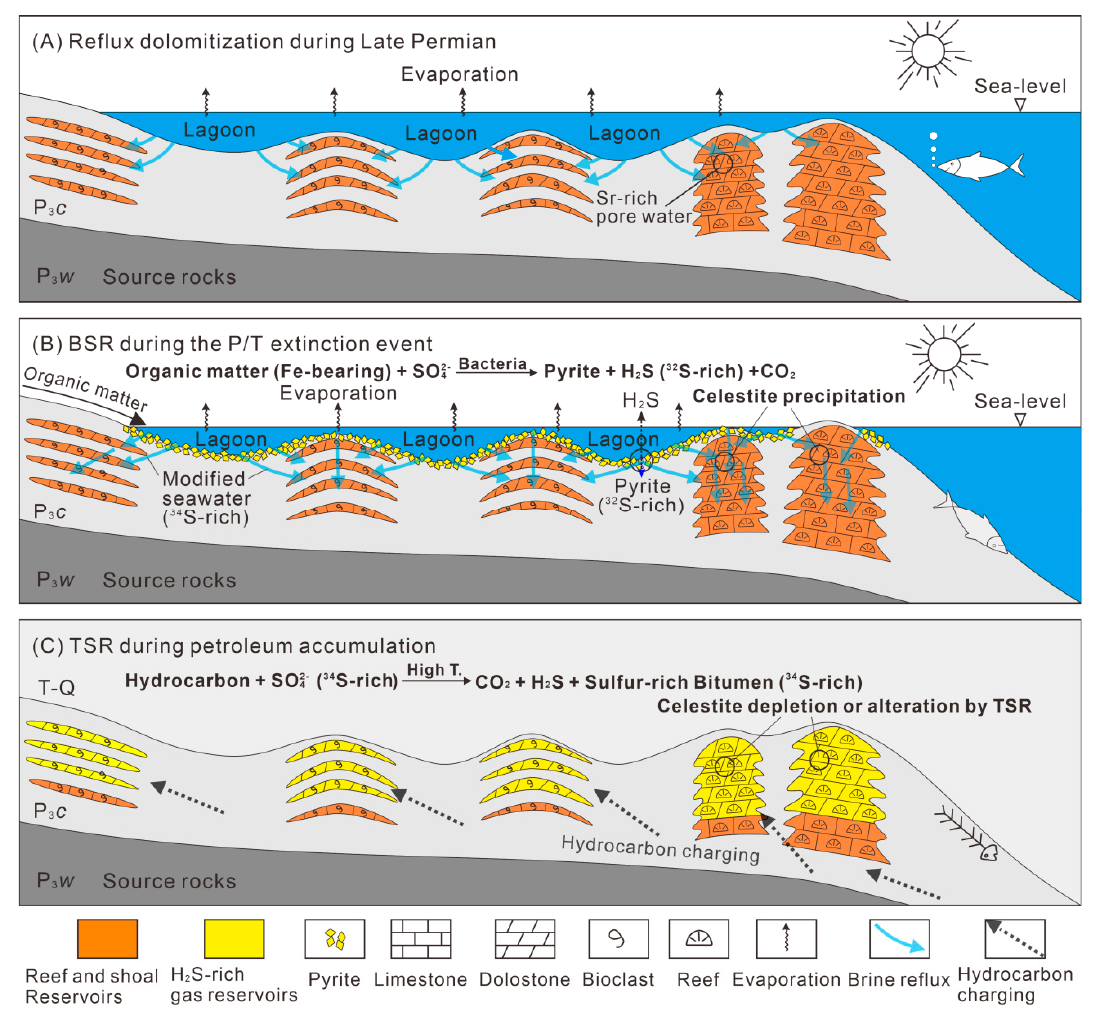
Figure 11. A schematic model for the formation of celestites, as well as the sources and evolution of sulfates. ( A ) Reflux dolomitization during Late Permian. ( B ) BSR during the P/T extinction event. ( C ) TSR during petroleum accumulation. See text fordetails. T., Temperature.